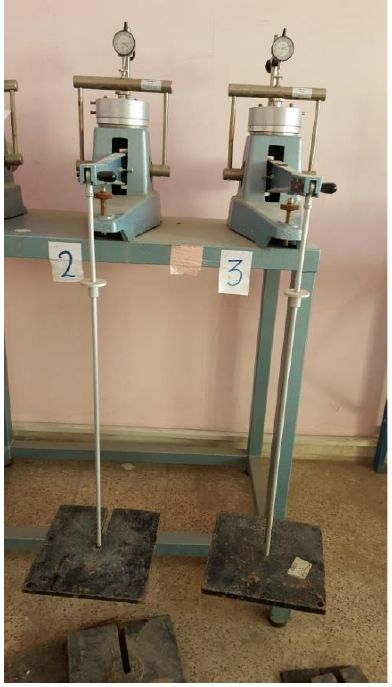
Figure 3. Consolidation test.